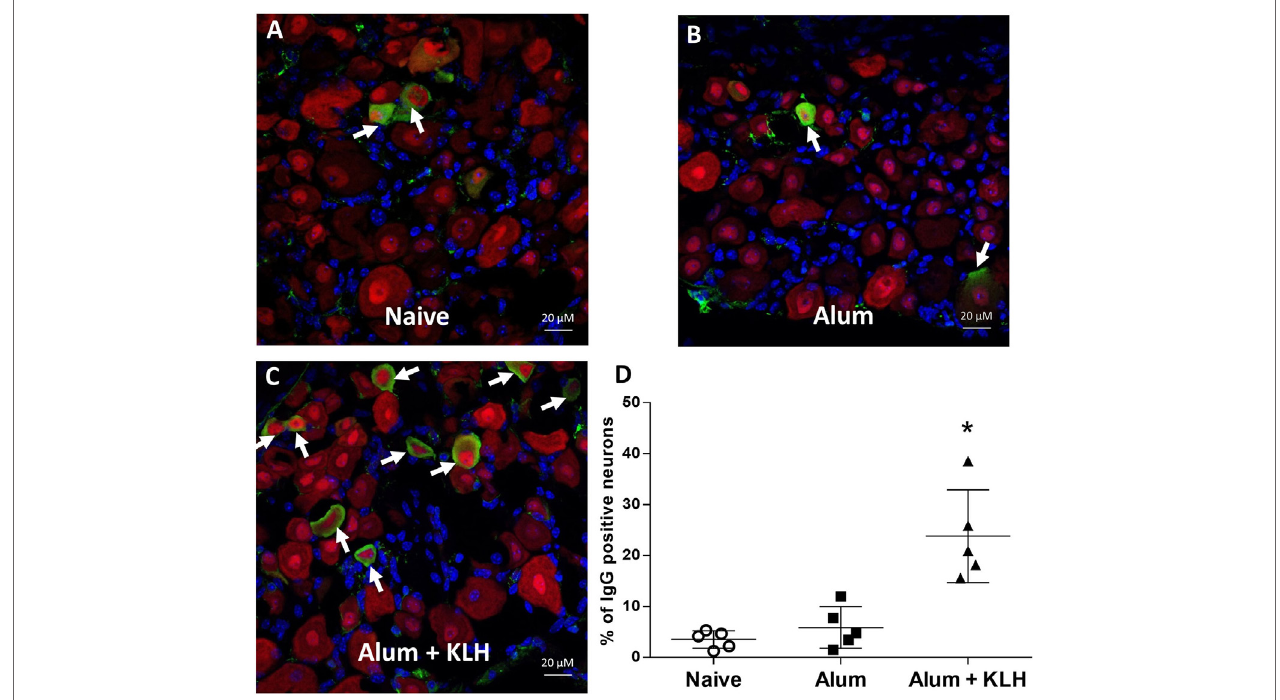
FigUre 1 | Sensory neurons of the mouse dorsal root ganglia (DRGs) exhibit abundant IgG reactivity. Immunohistochemical staining of whole DRGs isolated from (a) naïve, (B) alum-injected, and (c) alum + KLH-immunized C57BL/6J mice to detect neurons (NeuN, red), IgG (green), and nuclei (DAPI, blue). 400 × magnification; scale bar = 20 µm. (D) Percentage of double IgG-positive, NeuN-positive neurons (among total NeuN-positive neurons) in DRGs isolated from naïve, alum-injected, and alum + KLH-immunized mice ( n = 5 per group). A total number of 824, 1,343, and 814 NeuN + DRG neurons were assessed for immunostaining for the naïve, alum-treated and alum + KLH-immunized mice, respectively. Data are shown as mean percentage ± SD. * P < 0.05 vs naïve DRGs Kruskal–Wallis one way ANOVA (followed by Dunn’s Multiple Comparison